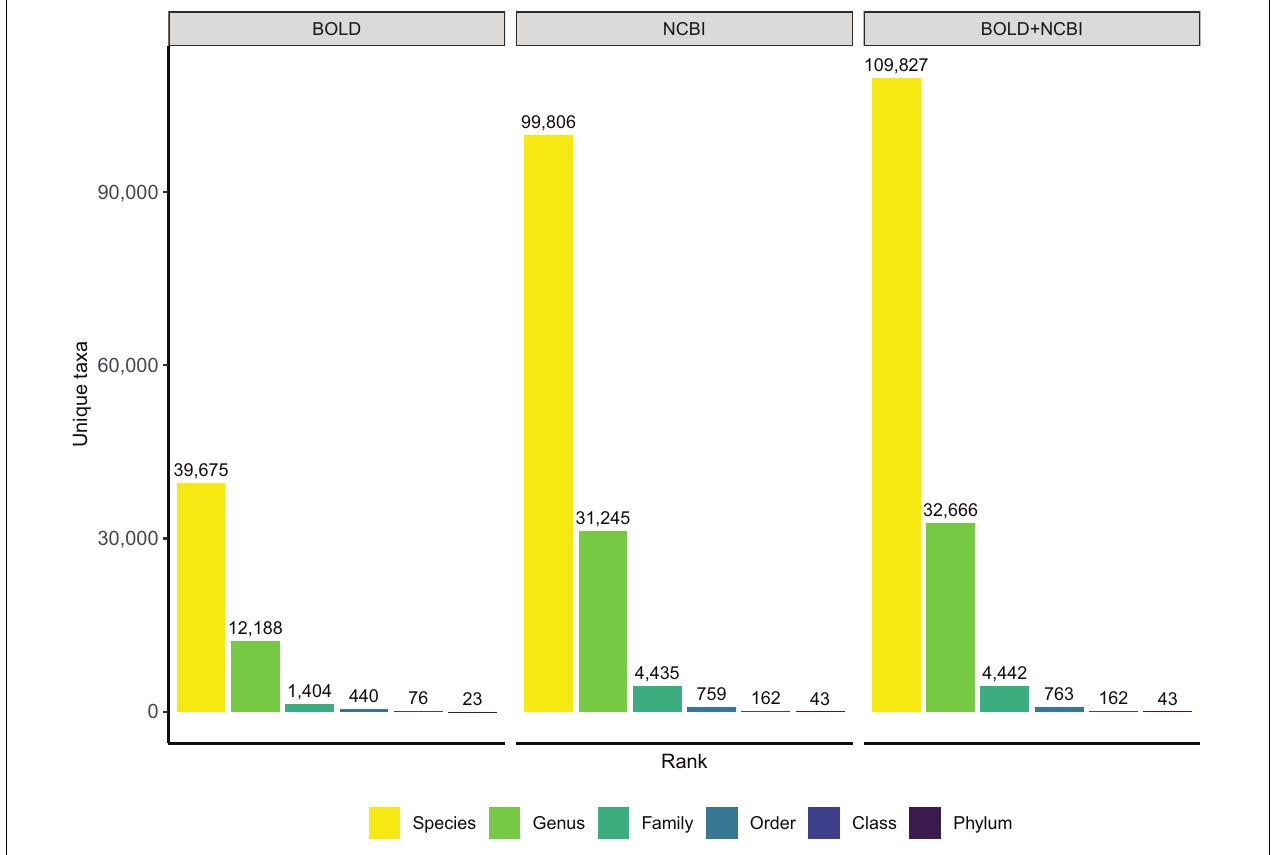
FIGURE 5 | Merging COI sequences from the BOLD and NCBI nucleotide database improves taxonomic coverage. Comparison of high-quality eukaryote COI reference sequences at a variety of ranks. Data is based on the BOLD data releases (no more than 3 Ns in the barcode sequence and at least 500 bp long), the NCBI nucleotide database accessed April 2019 (no Ns, at least 500 bp long, human and bacterial contaminants removed), and the combined database released in the CO1 Classifier v4 that merges data from BOLD and